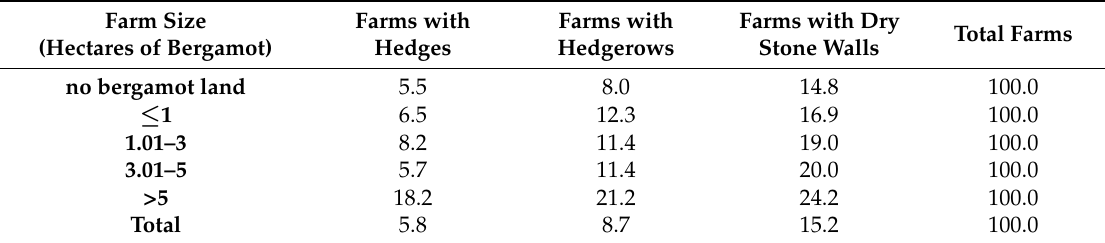
Table 5. Components of landscape (hedges, rows and dry-stone walls) by farm size in the study area (% of total farms of each size group).